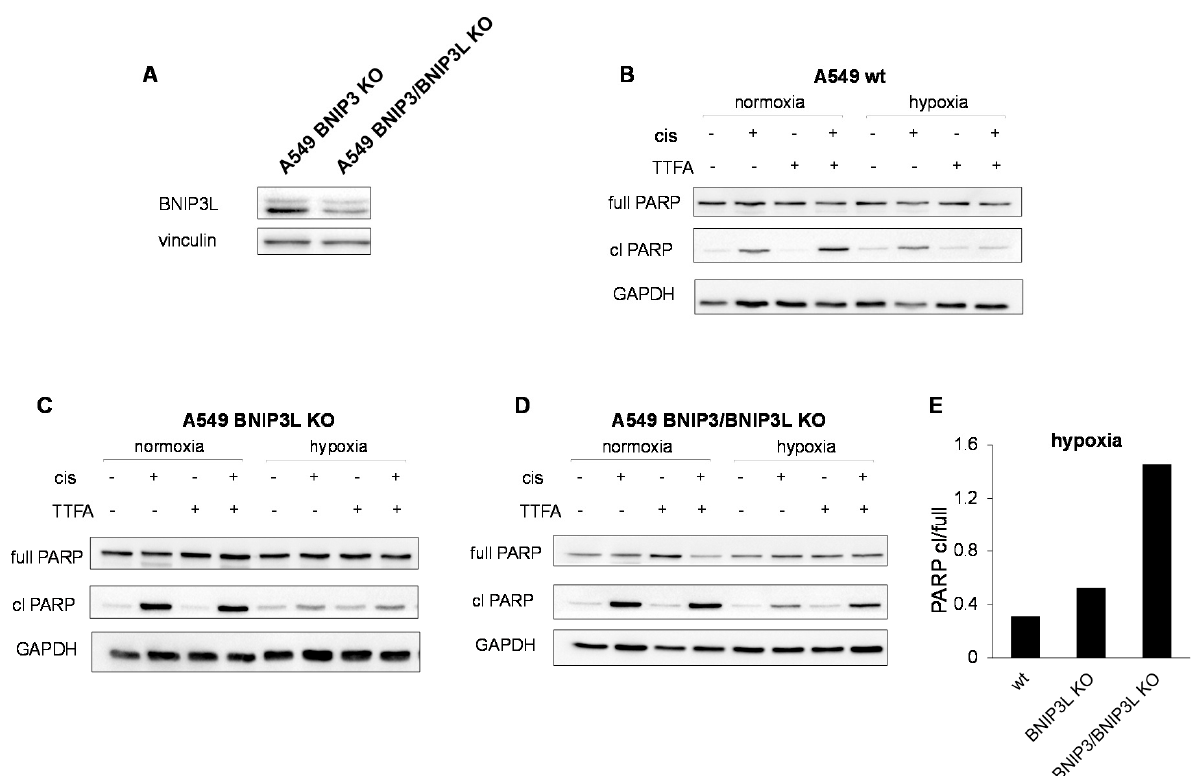
Figure 6. The role of BNIP3L in hypoxia-mediated suppression of apoptosis. The level of BNP3L in A549 cells lacking BNIP3 and in cells with BNIP3 double knock-out ( A ), assessment of PARP cleavage in wild-type ( B ), BNIP3L KO ( C ), BNIP3 and BNP3L double KO ( D ) A549 lung adenocarcinoma cells under hypoxic and normoxic conditions. (Panel E ) represents the ratio of cleaved PARP to full length PAPR in cells treated with cisplatin and TTFA under hypoxic condi- tions.